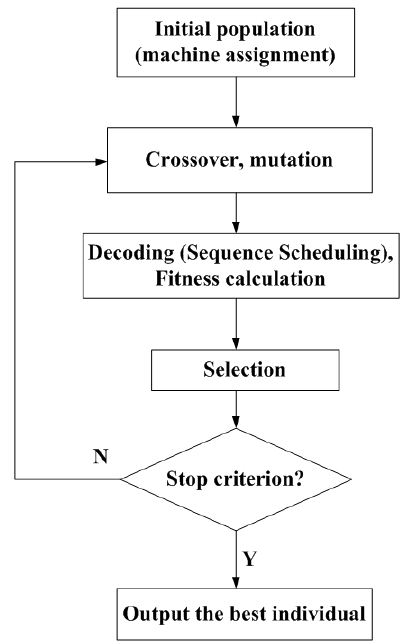
Figure 2. Flowchart of integrated GA for